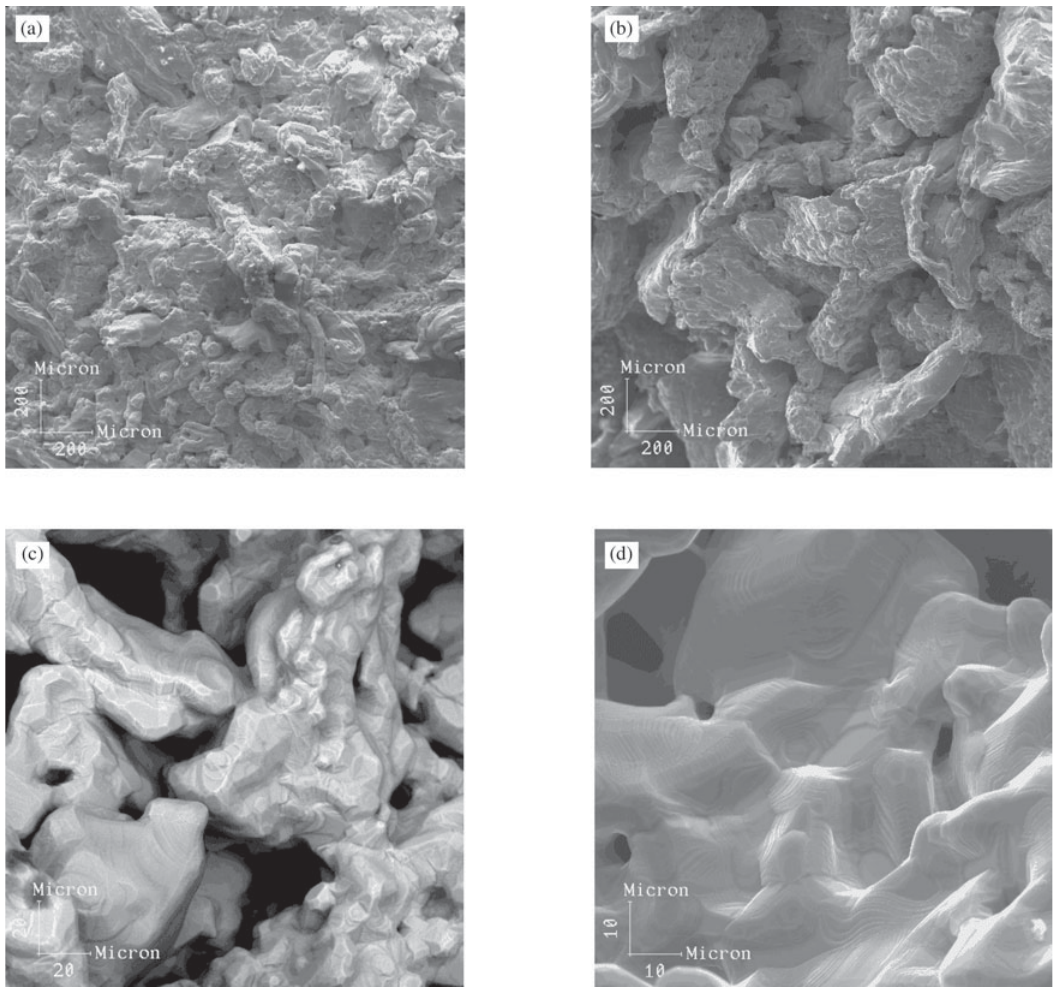
Figure 2. SEM surface topographical images of the specimens compacted at 200 MPa:type 2 in (a) (c); type 4 in (b), type 1 in (d).